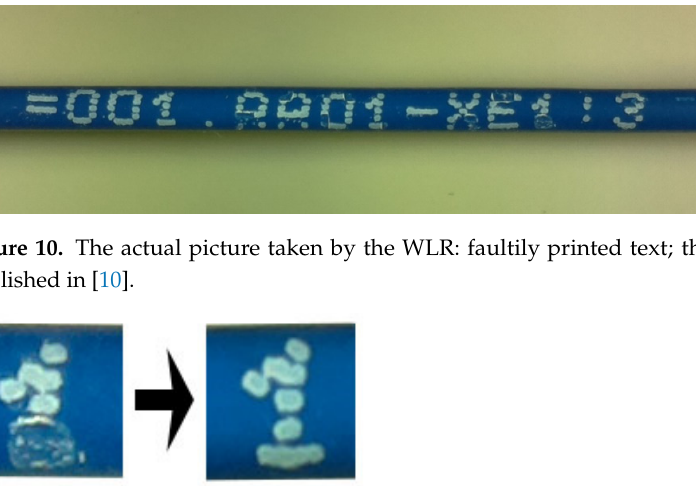
Figure 11. An enlargement of a single character: digit, printed on a wire: left side, a faultily printed text with a digit that the AI-supported system is challenged to recognize; right side: the result of AI-recognition, giving relevant pattern simulation; the figure was previously published in [10].